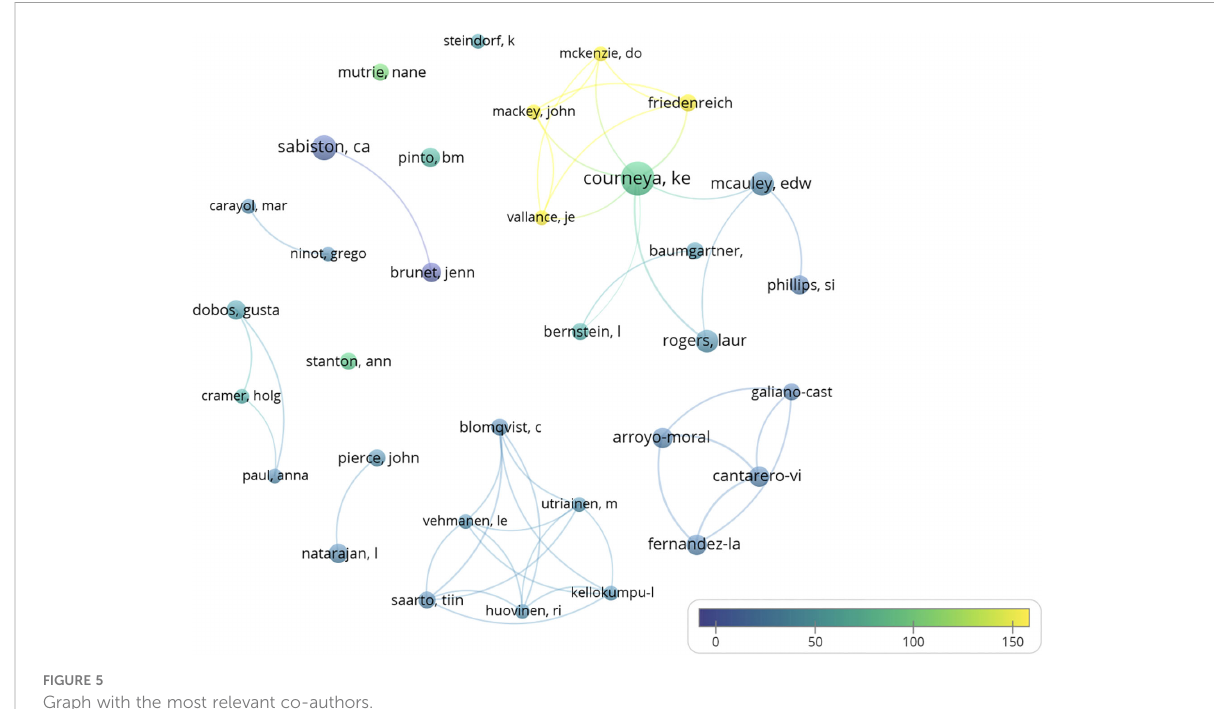
FIGURE 5 Graph with the most relevant co-authors.